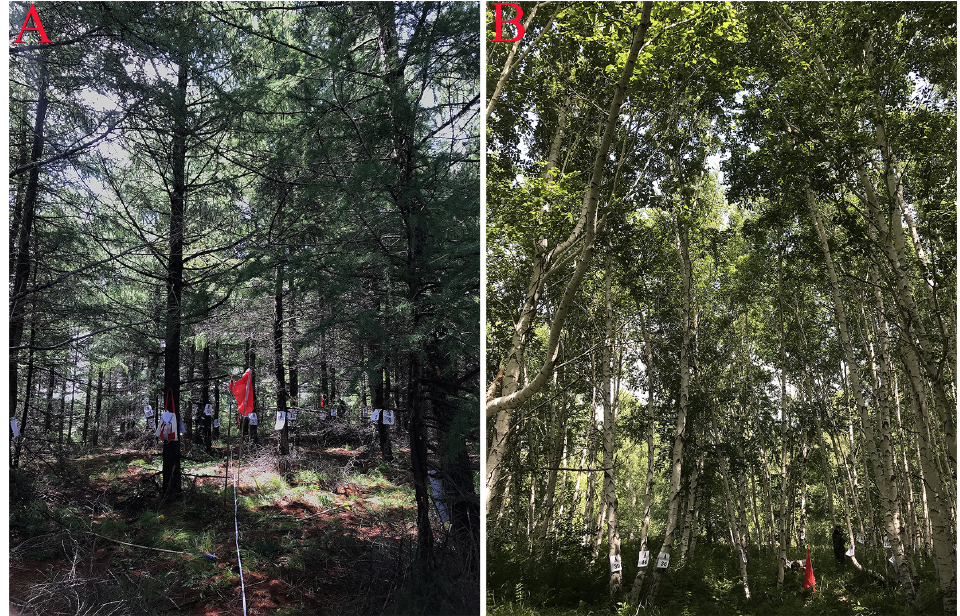
Figure 2. ( A ) Larix gmelinii plot. ( B ) Betula platyphylla plot. Table 1. Tree species and DBH parameters at the sample site.